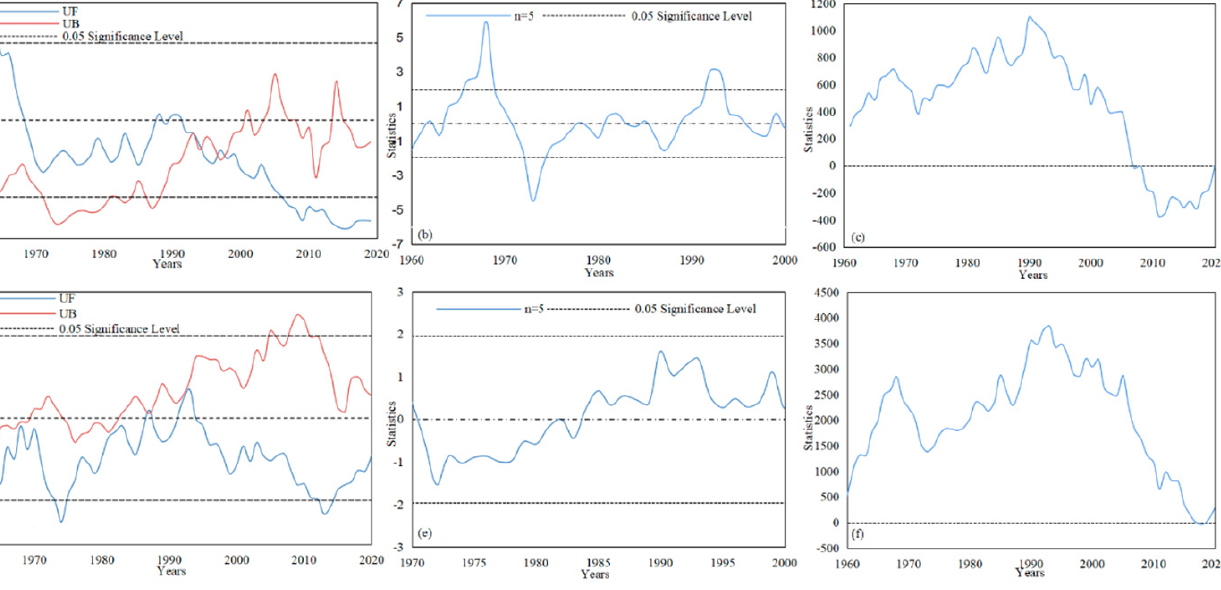
Figure 2. Alteration test analysis curve. ( a ) Runoff: M—K; ( b ) runoff: sliding t -test; ( c ) runoff: cumulative distance level; ( d ) precipitation: M—K; ( e ) precipitation: sliding t -test; ( f ) precipitation: cumulative distance